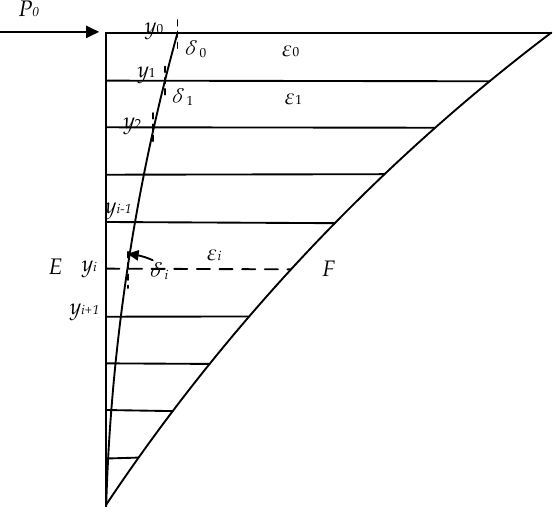
Figure 5. Nonlinear displacement of strain wedge model.